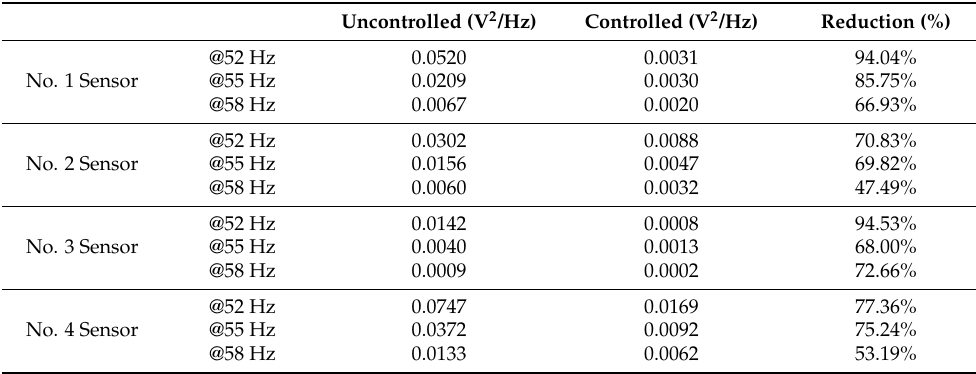
Figure 13. Sensor signals obtained by experiments (1 mV represents 0.1 m/s 2 ). Table 4. Peak values of PSD curves of sensor signals: Experiment